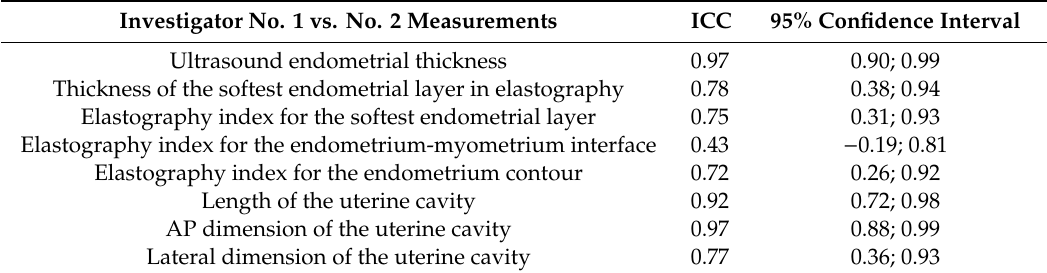
Table 2. The intraclass correlation coe ffi cient (ICC; individual) for the two-way mixed-e ff ects model, 95% confidence interval for this coe ffi cient were calculated to analyze the consistency of agreement for the measurements carried out by the first and second